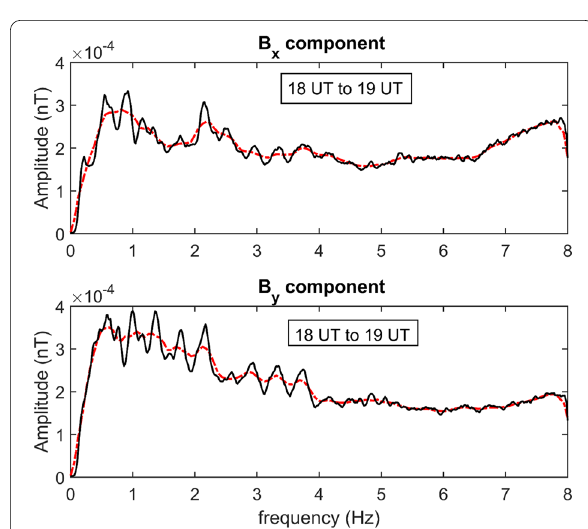
Fig. 10 Power spectra of B x and B y component observed on December 4, 2018. The solid black line is the power spectra with frequency resolution of 0.0156 Hz and dashed red line denotes the frequency resolution of 0.0625